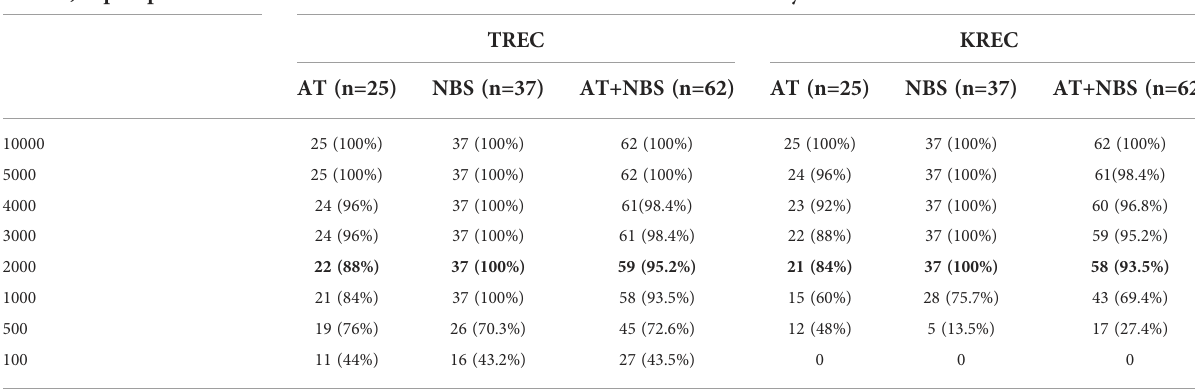
TABLE 4 Sensitivity of method depending on TREC/KREC cut-offs levels in patients of controls (AT and NBS patients). С ut-off, copies per 10 6